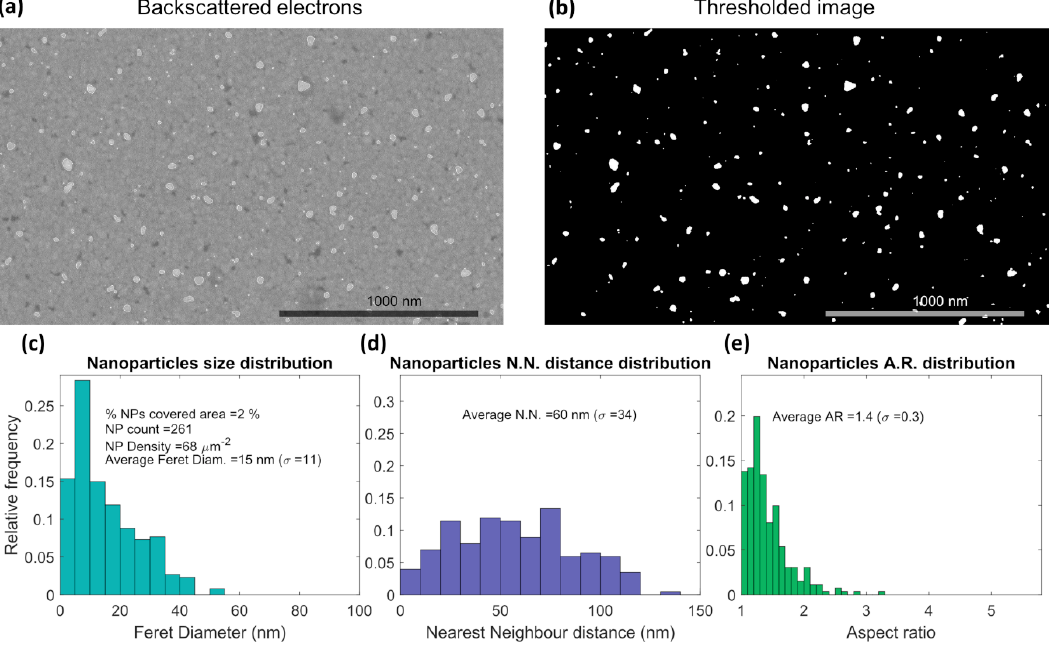
Figure 5. Ag nanoparticle distribution analysis, using a MATLAB algorithm: ( a ) top-view SEM micrograph with atomic weight contrast and ( b ) processed and threshold micrograph showing the exposed Ag nanoparticles, with 2% Ag coverage area. Distribution histograms are displayed in ( c ) for nanoparticles Feret diameter, ( d ) for the nearest neighbor distance, and ( e ) for the aspect ratio.